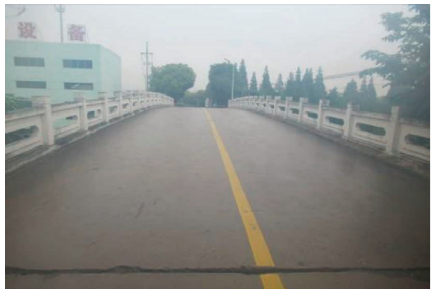
Figure 3: Frontage view of the bridge.